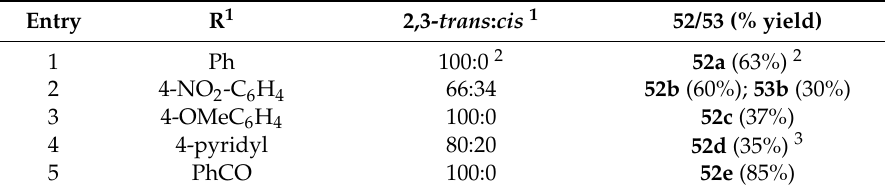
Table 7. Cycloaddition of azomethine ylide 51 to aromatic aldehydes 2 (Scheme